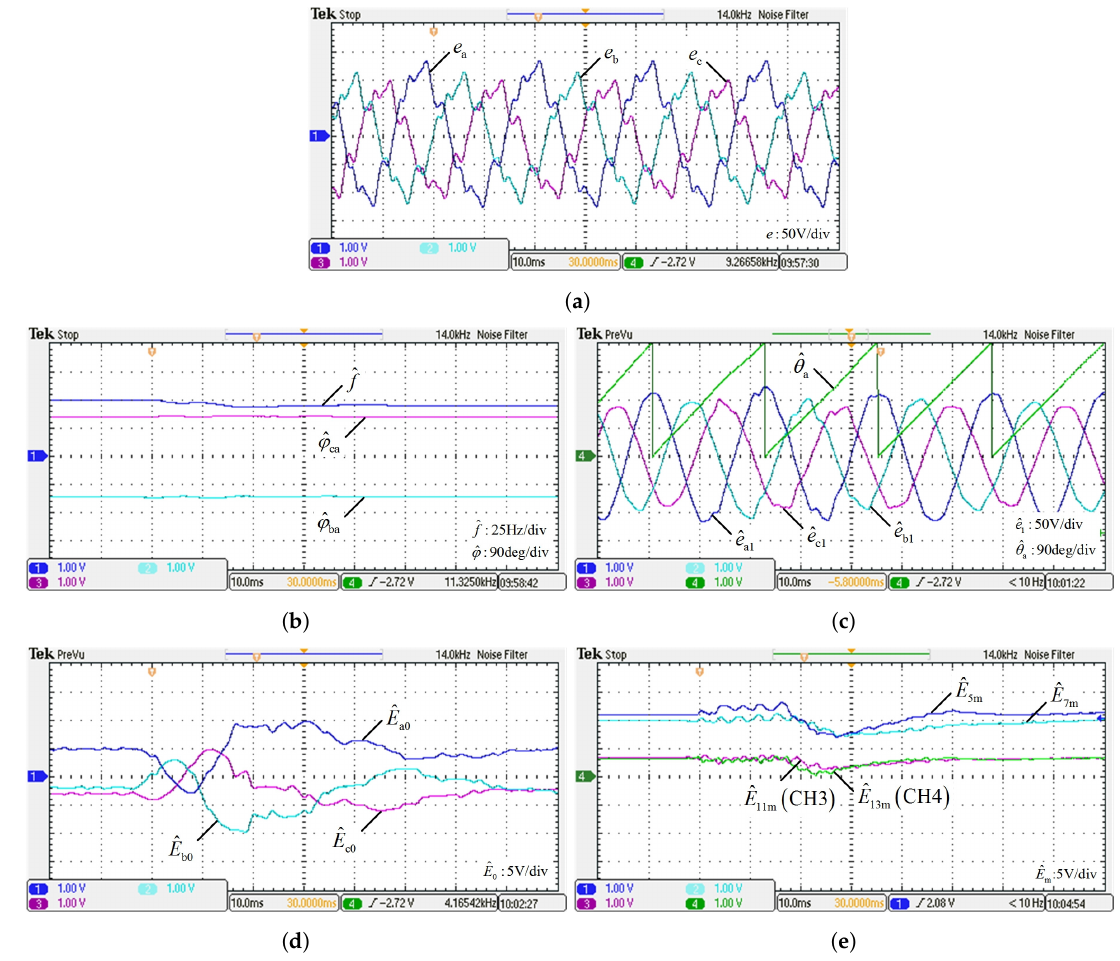
Figure 14. Experimental results when the grid frequency f has a step change from 50 Hz to 45 Hz. The waveforms of ( a ) e abc ; ( b ) ˆ f , ˆ ϕ ba , and ˆ ϕ ca ; ( c ) ˆ e abc and ˆ θ a ; ( d ) ˆ E abc0 ; ( e ) ˆ E 5m , ˆ E 7m , ˆ E 11m , and ˆ E 13m